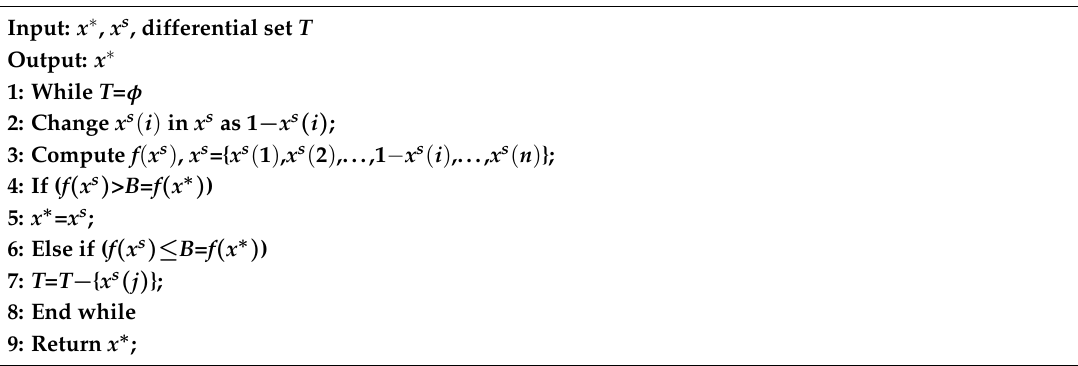
Algorithm 4. Solution promotion